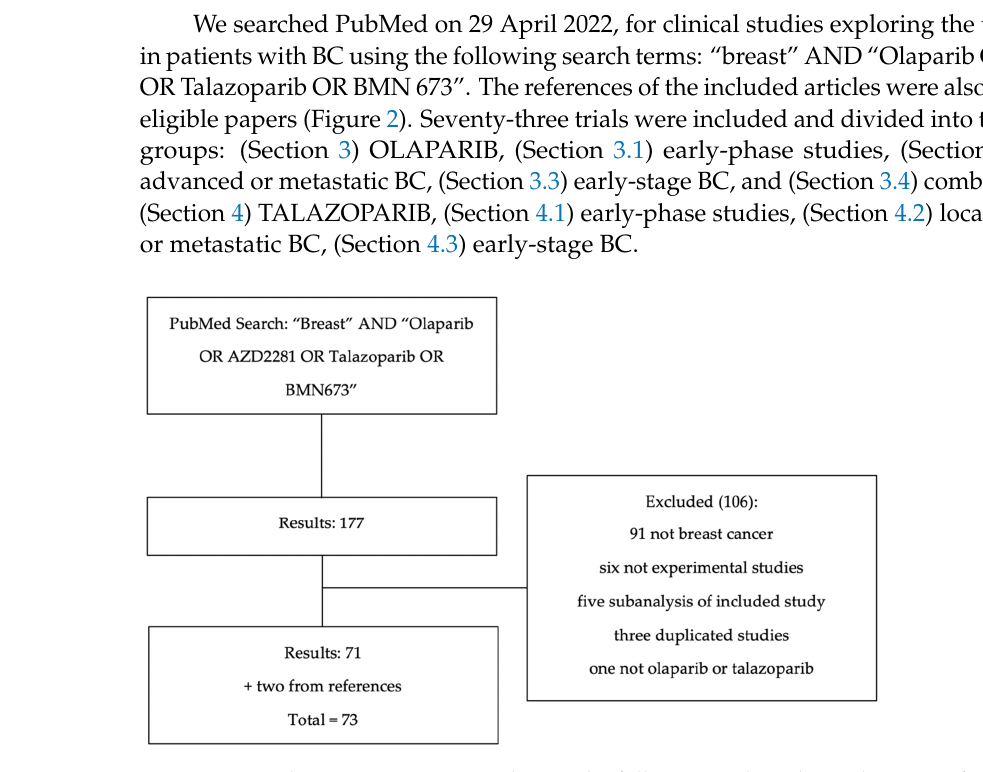
Figure 2. Search strategy . On 29 April 2022, the following PubMed search was performed: “breast” AND “Olaparib OR AZD2281 OR Talazoparib OR BMN673”. The references were also scanned for